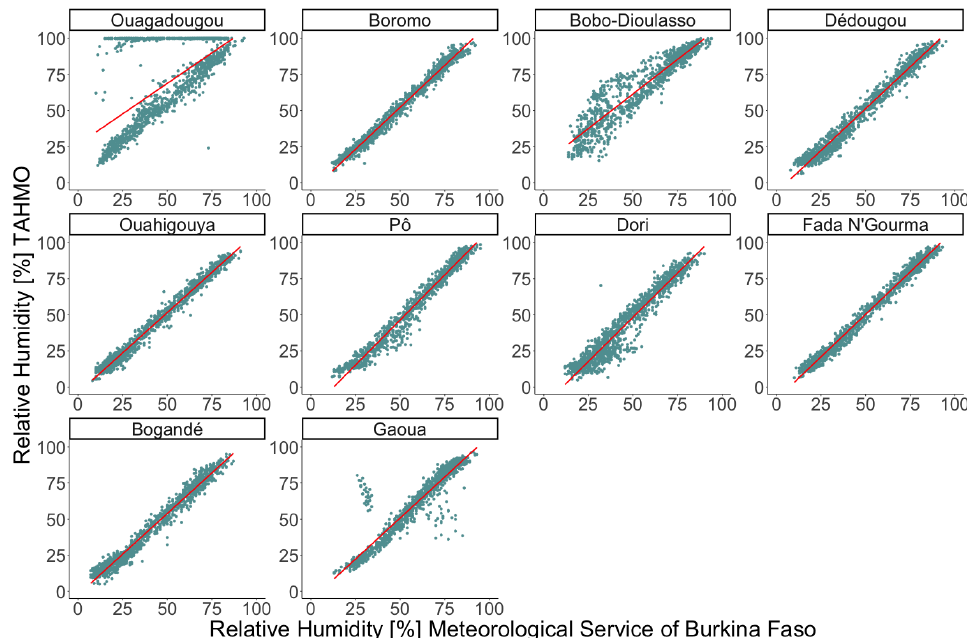
Figure 15. Scatterplot between relative humidity time series of TAHMO stations ( y -axis) and the corresponding stations from meteorological service of Burkina Faso ( x -axis). For TA00160 in Oua- gadougou, a large number of artifacts can be